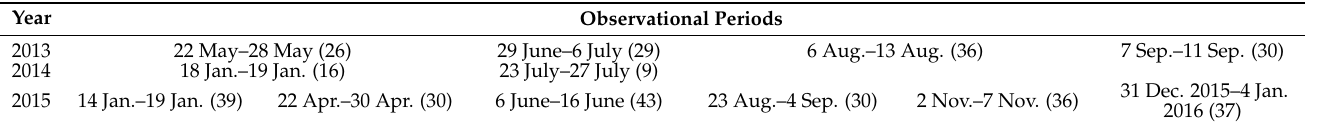
Table 1. Observation periods for O 3 and BVOC emission flux measurements. The numbers in parentheses are the number of emission flux